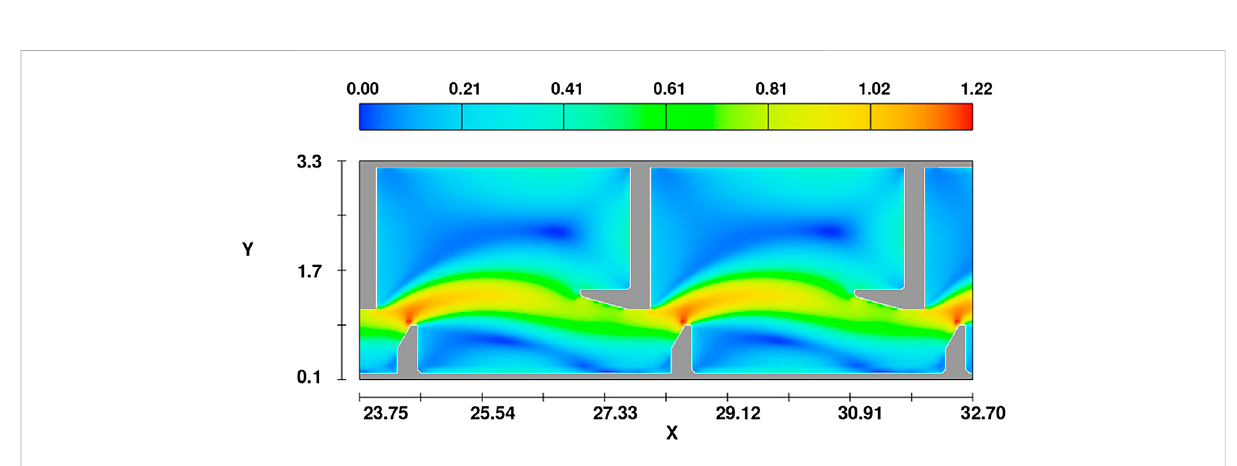
FIGURE 7 Velocity distribution diagram of the